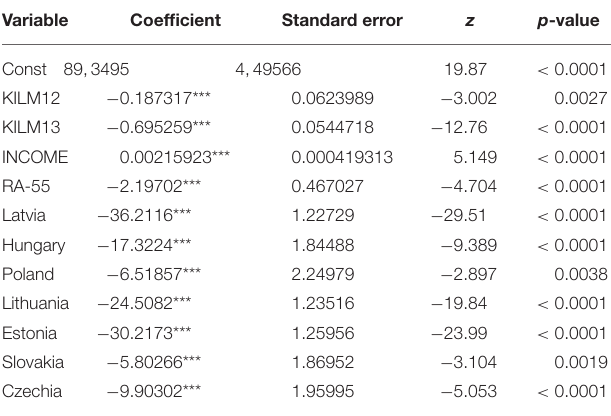
TABLE 13 | GMM model 3, dependant variable—SP18(f). Variable